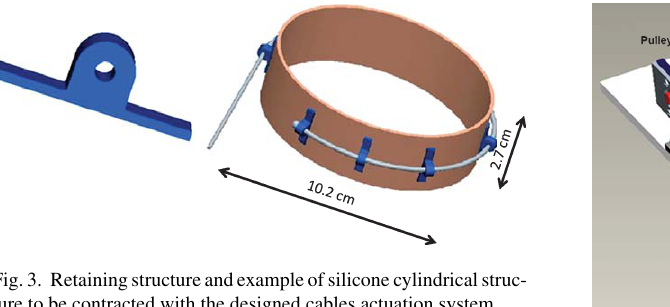
motility events. They defined the relative occlusion of ACW (antral contraction wave) as: